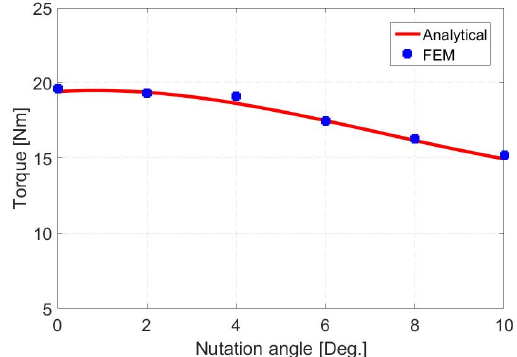
Figure 10. Comparison of the calculated torques with the nutation angle by the analytical model and FEM.